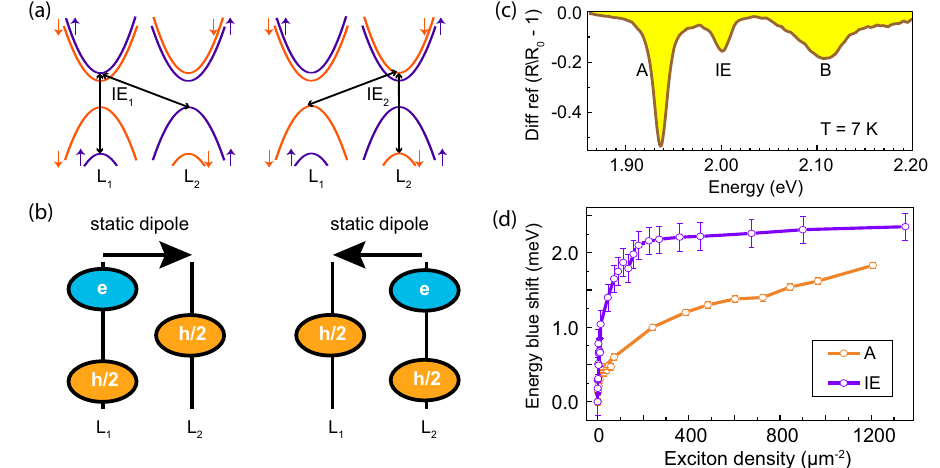
Fig. 1 | Excitons in MoS 2 bilayer and white light absorption. a Schematic of the bandstructure(aroundtheKpoint)ofthebilayerMoS 2 showing(blackarrows)the participation of the different bands in the IE formation. The blue and red colors representtheupanddownspin,respectively.L 1 andL 2 refertothelayer1andlayer 2 of the bilayer MoS 2 , respectively. b Schematic showing the two possible charge con fi gurationsintheabsenceofbiasvoltagebetweenthetwolayers.Inbothcases, theelectronislocalizedinoneofthelayers,andtheholeisdistributedamongboth